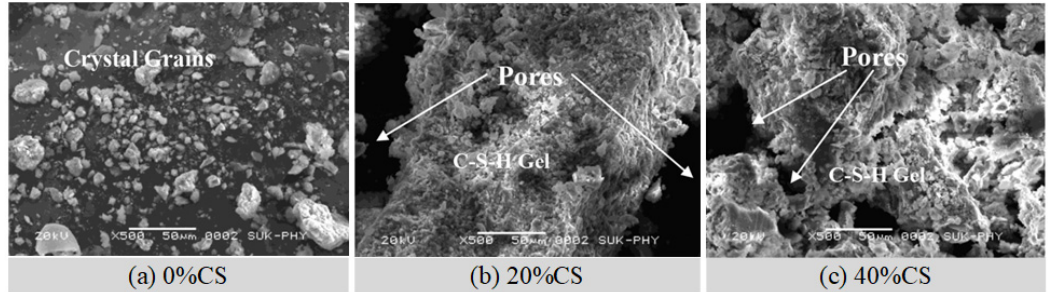
Figure 9. SEM images of the paste containing CS aggregate. ( a ) 0% CS, ( b ) 20% CS, and ( c ) 40% CS [94].